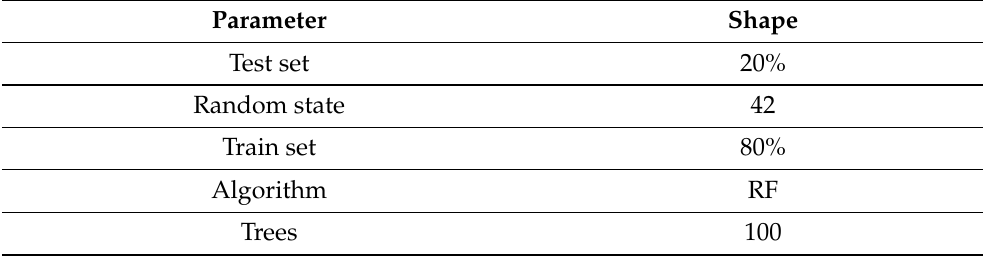
Table 7. Specifications Model of